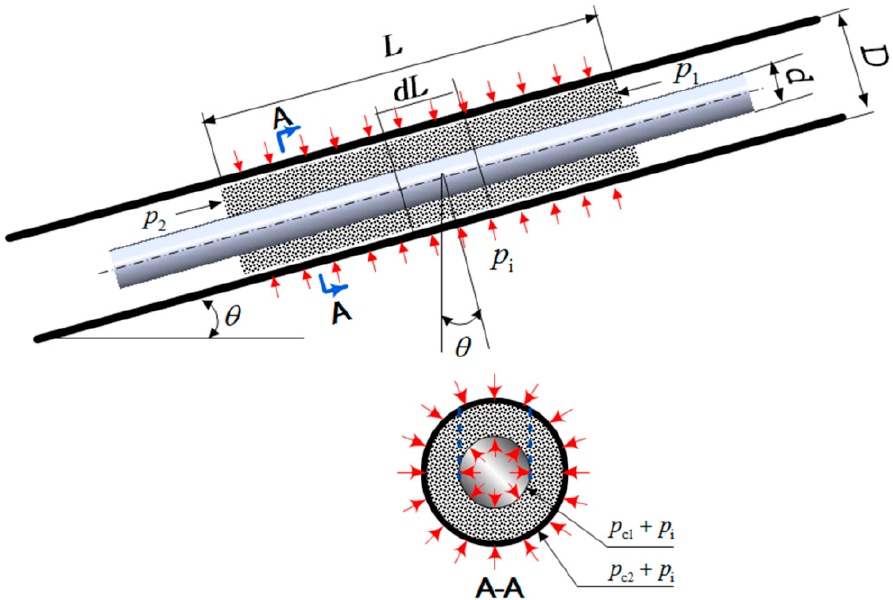
Figure 4. The mechanical model of a clogging segment in an upward borehole.